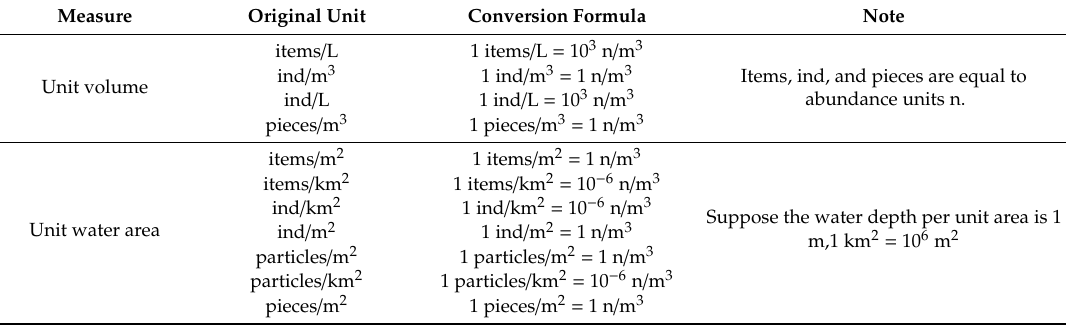
Table 2. Di ff erent system unit conversion comparison table for microplastic